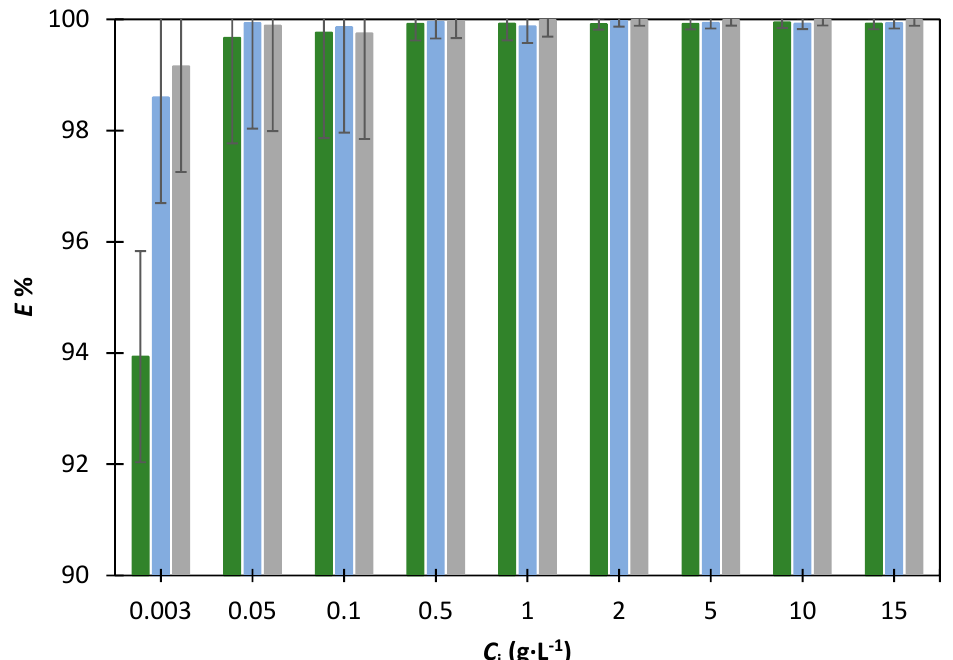
Figure 1. Extraction efficiency ( E %) versus initial concentration ( C ) of phenol ▬ , i ) of phenol ▬ , o-cresol ▬ and 2-chlorophenol ▬ for the extraction using [EMim][DCA] and i ) of phenol ( ▬ ), 30% of K PO i 3 4